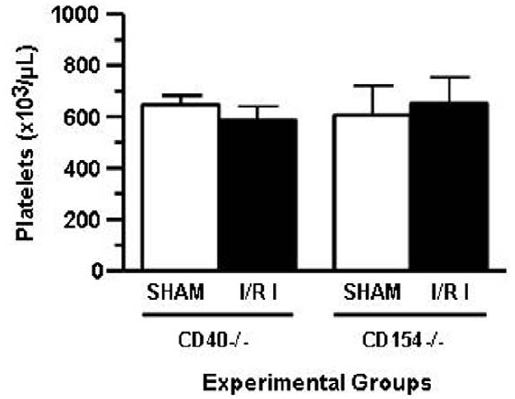
Figure 2. Platelets numbers are not decreased in CD40 2 / 2 and CD154 2 / 2 mice after mesenteric ischemia/reperfusion. CD40 2 / 2 and CD154 2 / 2 mice were bled before and after mesenteric I/R via cardiac puncture. Platelet numbers were determined using Hemavet 850 (Drew Scientific, Farmington, CT).